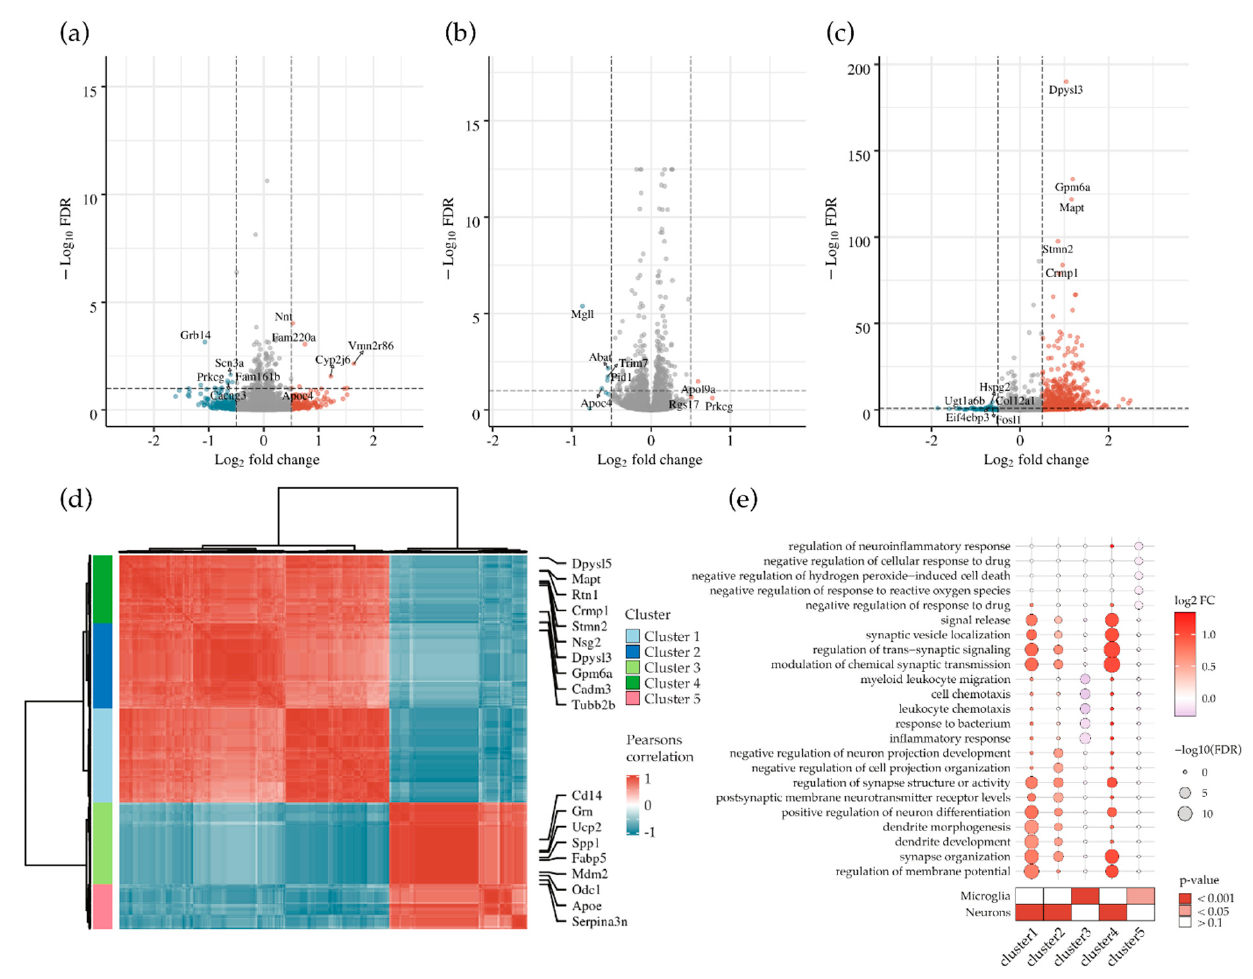
Figure 6. Abrogation of MECP2 phosphorylation at S423 changes global transcription in primary cortical neurons co- cultured with BV2 cells upon LPS/IFN γ -induced neuroinflammation. Volcano plot representation of differentially expressed genes for ( a ) MECP2-WT compared to Control (ZsGreen1), ( b ) MECP2-S80A compared to MECP2-WT and ( c ) MECP2- S423A compared to MECP2-WT expressing primary cortical neurons co-cultured with BV2 cells upon LPS/IFN γ -induced inflammation. Significantly (FDR-adjusted p -value < 0.1 y-axis, dotted line) down- (blue, log2 fold-change < 0.5) and upregulated (red, log2 fold-change > 0.5) genes and their log2-transformed fold-changes (x-axis) from n = 4 samples. ( d ) Clustered correlation matrix (Pearson correlation) for differentially expressed genes in MECP2-S423A compared to MECP2-WT. Highlighted are the top up- and down-regulated genes determined in differential expression analysis. ( e ) A dot plot to represent the top five enriched gene ontology (GO, biological processes) terms (y-axis) for each cluster (x-axis). The size of the symbol represents the FDR-adjusted p -value, the color represents the log2-fold change. Below, a heatmap representing neuron or microglia marker enrichment for each cluster. Color represents the FDR-adjusted p -value.